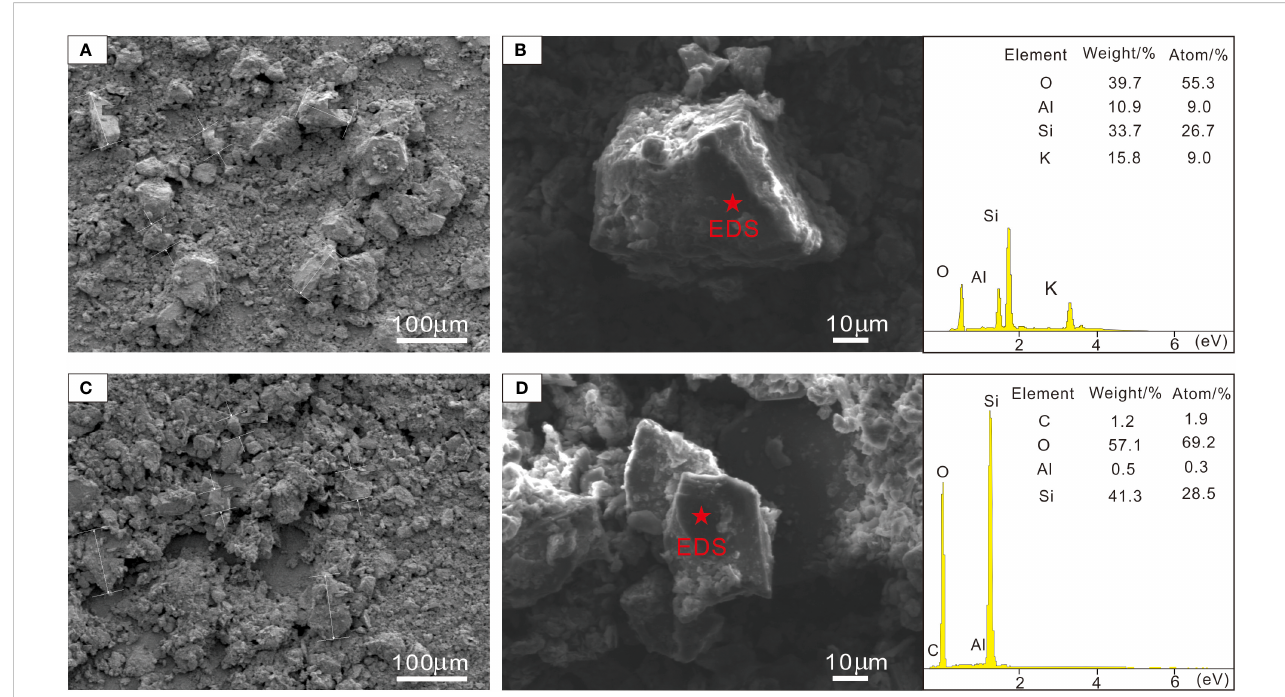
FIGURE 5 SEM and EDS images of sediments from core SCS18-1. (A, B) The SEM and EDS images sediments from core SCS18-1 at 40 cm depth. (C, D) SEM and EDS images of sediments from core SCS18-1 at 80 cm